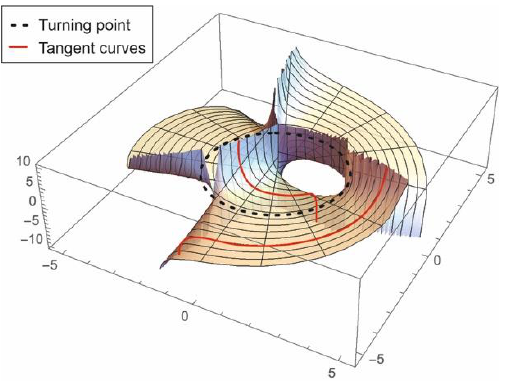
Figure 1. Example of a wavefront with warped profiles according to Equation (1). The blue lines represent the tangential profile while the dotted curve represents the turning point.